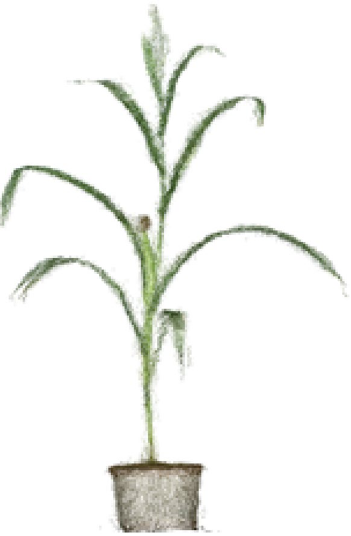
Figure 10. 3D reconstruction model after coarse registration.